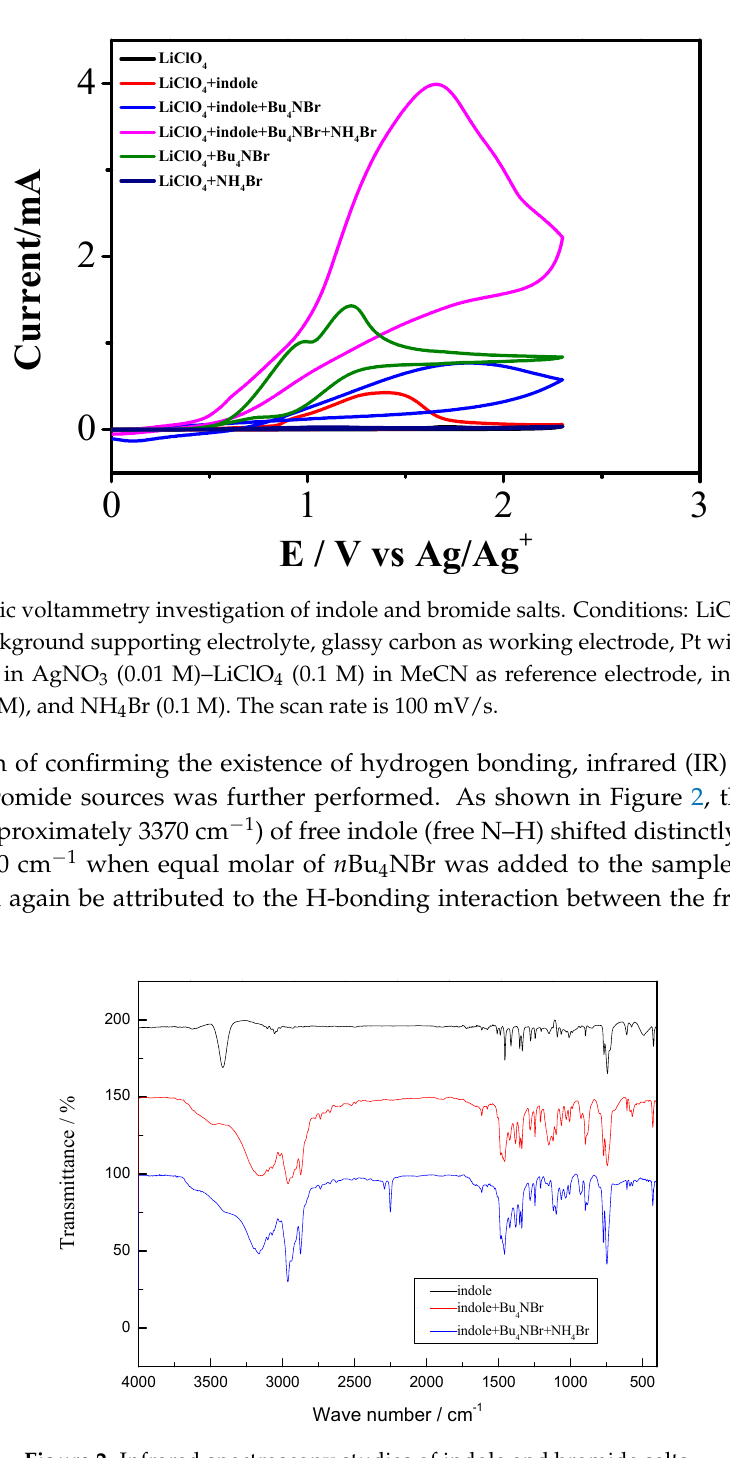
Figure 2. Infrared spectroscopy studies of indole and bromide salts.